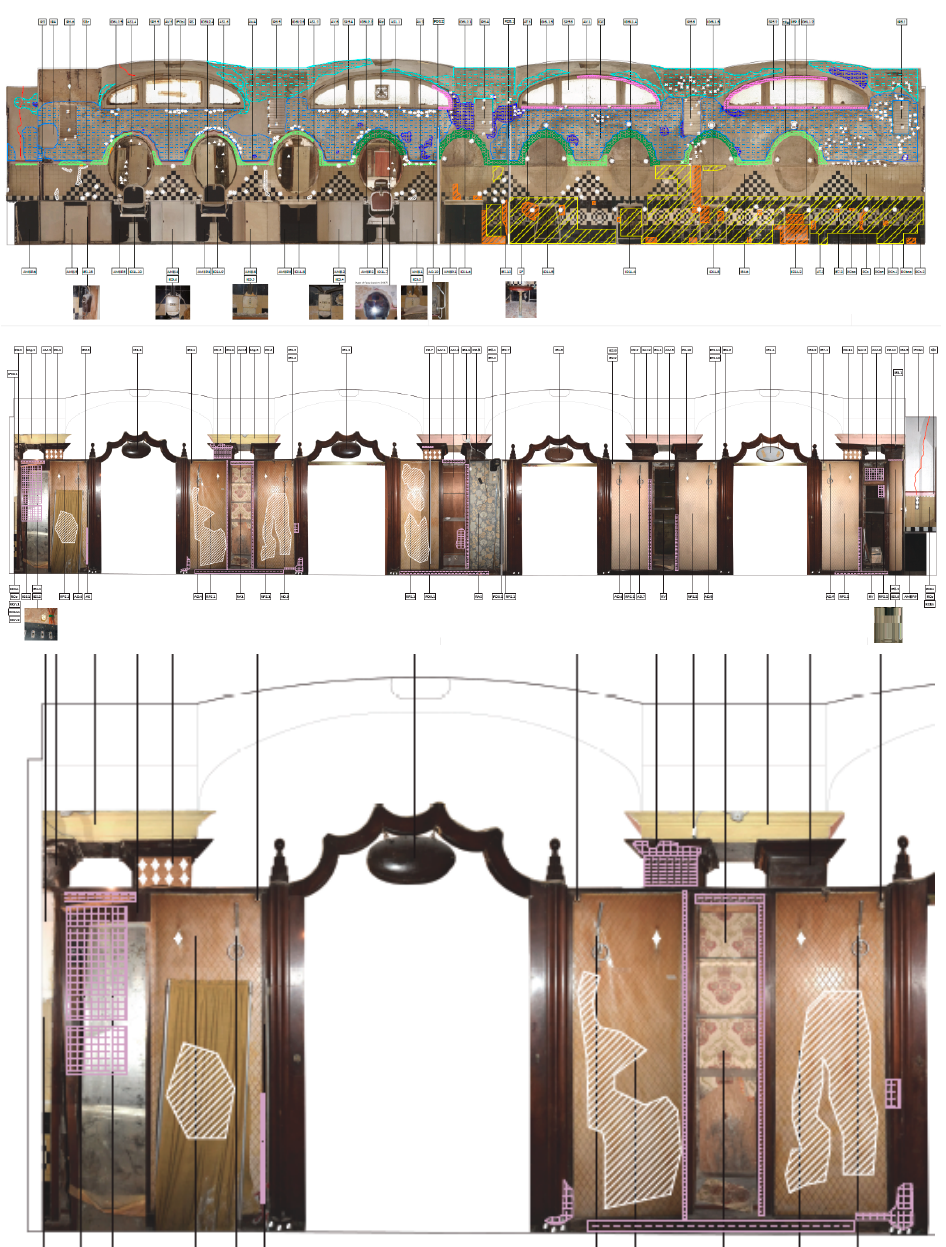
Figure 1. Example of material and condition identification using a mosaic of rectified images (computer-aided designdrawings produced by G. Colombo, F. Gaspari, L. Lori, P. Nardelli, R. Rapacciuolo, and G. Regazzoni in the framework of a restoration course at Politecnico di Milano). A detail is illustrated in the lower part of the figure.